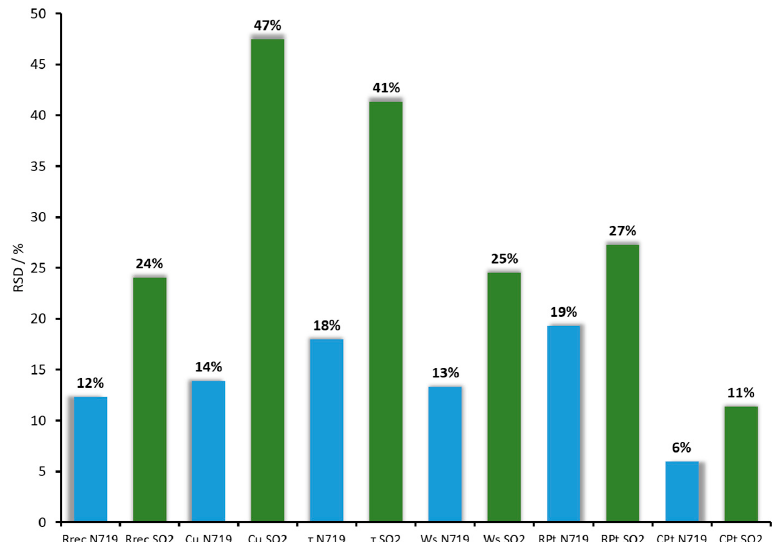
Figure 7. The overview of RSDs for N719 and SQ2 dyes. The blue bars refer to N719, and the green bars represent SQ2.